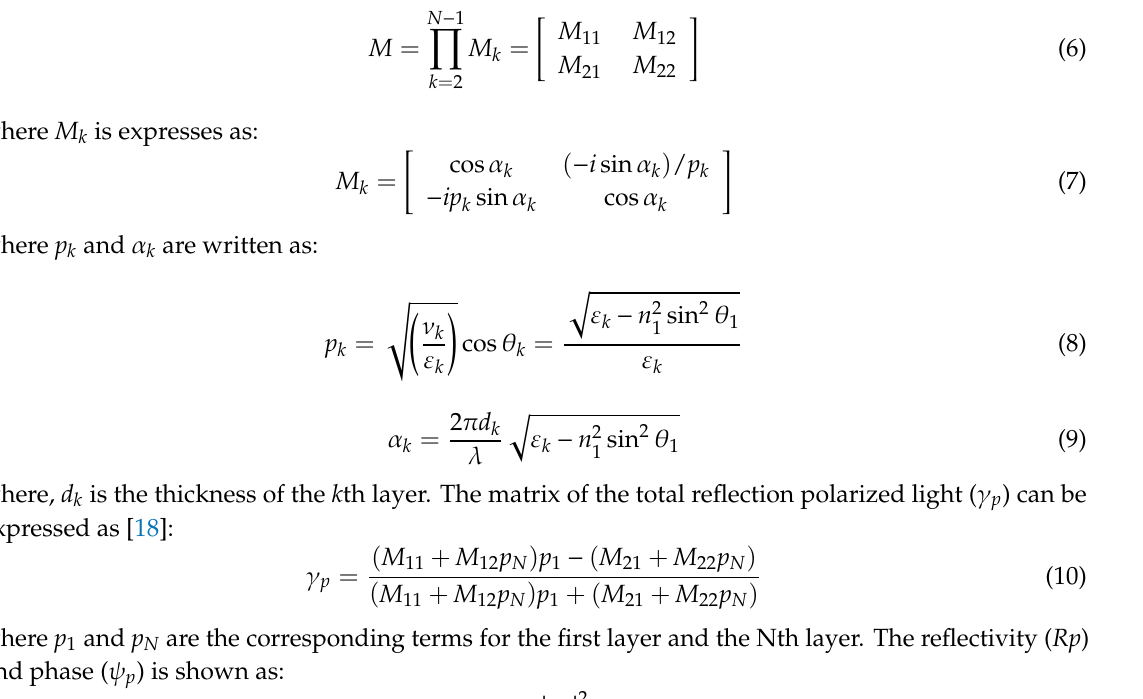
Figure 2. The change of ( a ) reflectivity and phase respect to angle of incidence; ( b ) Goos-Hänchen (GH) shift with respect to angle of incidence for Au-ITO structure.